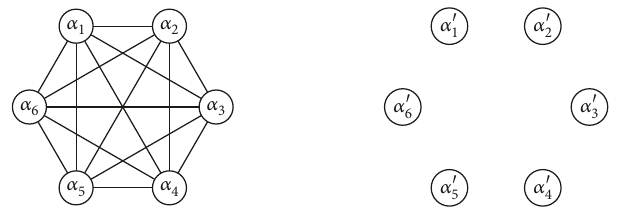
Figure 1: Dependency relationship of the different basis vectors of 𝑛 = 6 (left side: standard basis, right side: basis 𝐵 ).